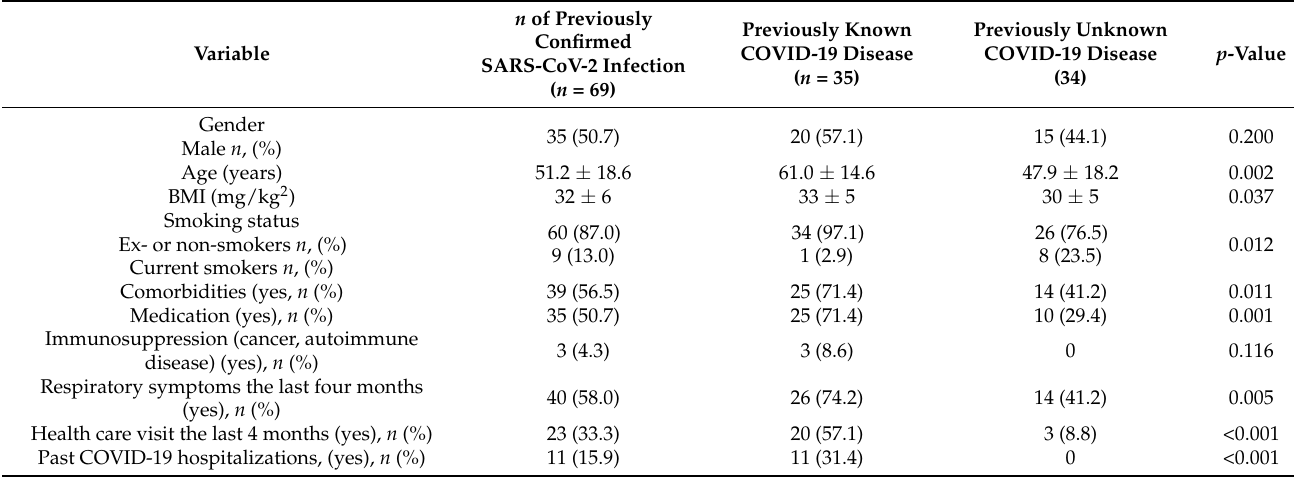
Table 4. The characteristics of the patients who tested positive and had previously confirmed SARS-CoV-2 infection compared to those diagnosed positive and were not aware of the past infection, n =